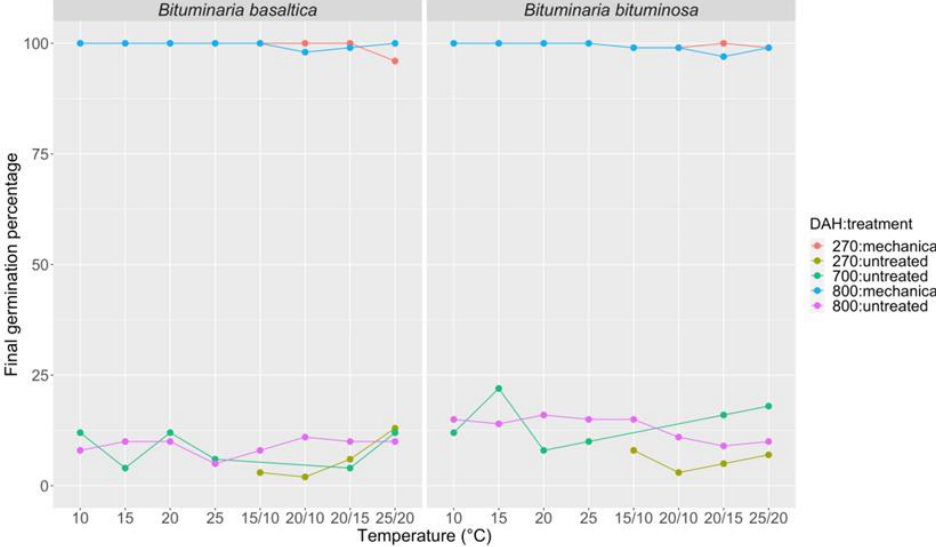
Figure 7. Final germination percentage at di ff erent incubation temperatures (10, 15, 20, 25, 15 / 10, 20 / 10, 20 / 15, 25 / 20 ◦ C) for B. basaltica and B. bituminosa seeds at 270, 700, and 800 days after harvesting (DAH); pods untreated and after mechanical scarification.